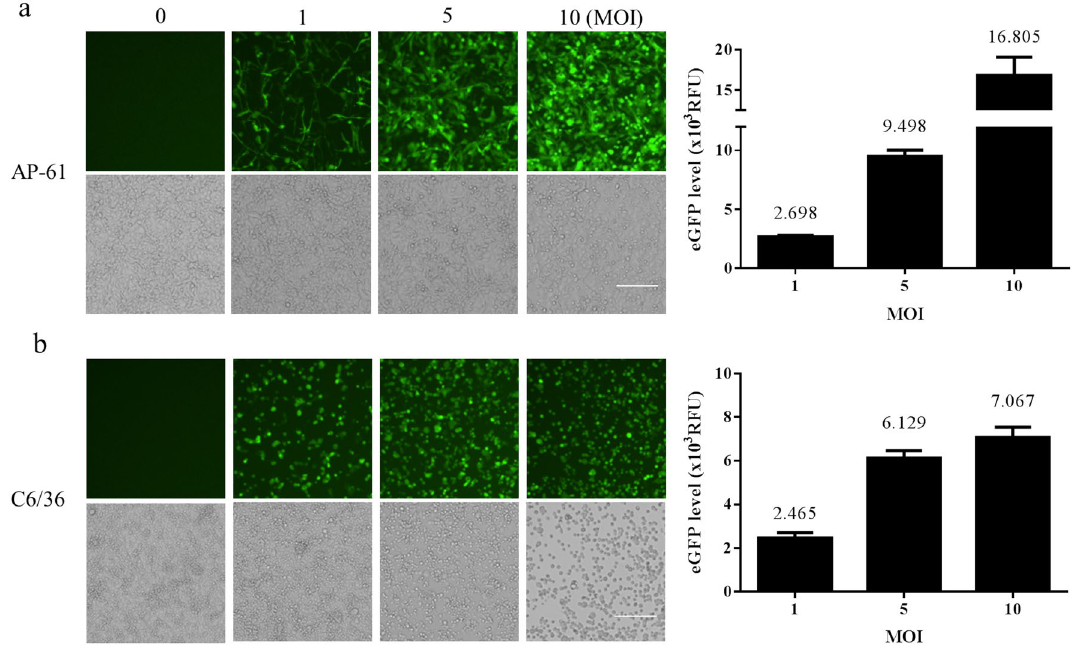
Figure 2. Autonomous CHIKV replicon-mediated expression of eGFP in baculovirus transduced into mosquito cell lines, AP-61 ( a ) or C6/36; ( b ) cells were transduced using WT/eGFP at indicated MOIs of 0, 1, 5 or 10 in triplicate. At 2 dpt, eGFP-expressing cells were photographed using green (upper panels) or bright field (lower panels) filters. Expression levels of eGFP were quantified (right part). Error bars represent the standard deviation.